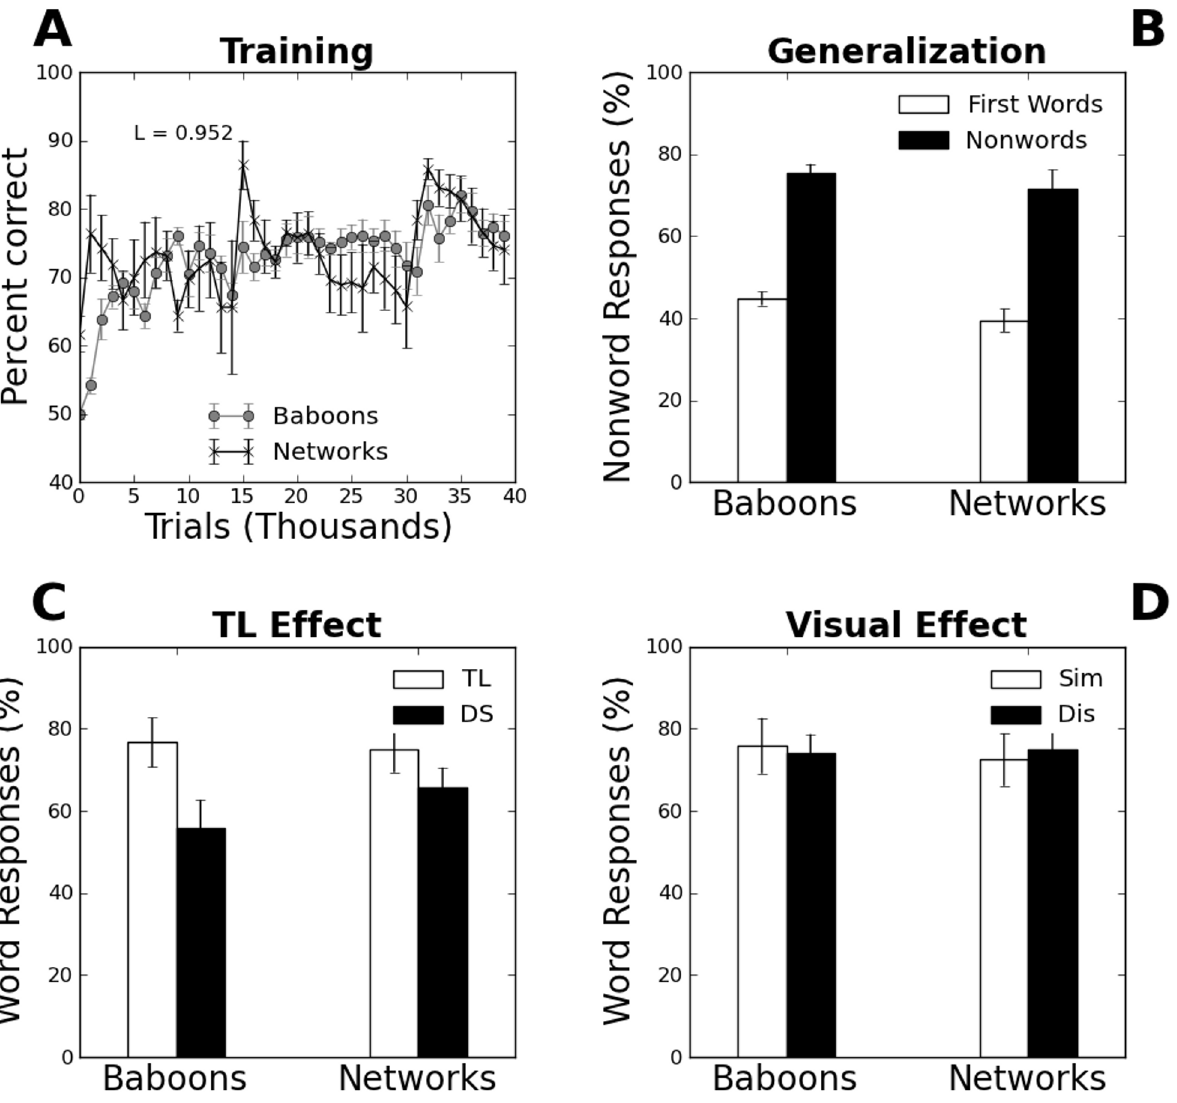
Figure 2. (A) Learning curves in the fitted model, showing the evolution in performance across traning trials in the networks (black crosses) and the baboons (gray dots). Only the first 40 000 trials are shown. (B) Generalization effect: percentage of nonword responses for baboons and networks upon presentation of a new word (white) during training, as opposed to the next nonword (black) in the sequence (experimental data from [1]). (C) Transposition effect: percentage of word responses produced in the networks and in the baboons upon presentation of nonword stimuli that differed from known words by two transposed letters (TL, white bars) or two letter substitutions (DS, black bars) (experimental data from [2]). (D) Visual similarity effect: word responses made on nonword stimuli that were visually similar (Sim, gray bars) or dissimilar (Dis, white bars) to known words (experimental data from [2]).